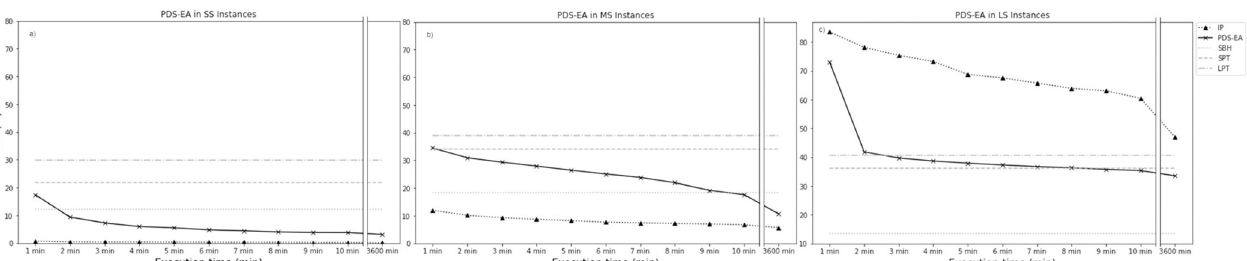
Fig 5. PDS-EA gaps for SS, MS, and LS instances. a. GAP values each minute of simulation Average GAP for SS instances; b. GAP values for each minute of simulation Average GAP for MS instances; c. GAP values each minute of simulation Average GAP for LS instances.